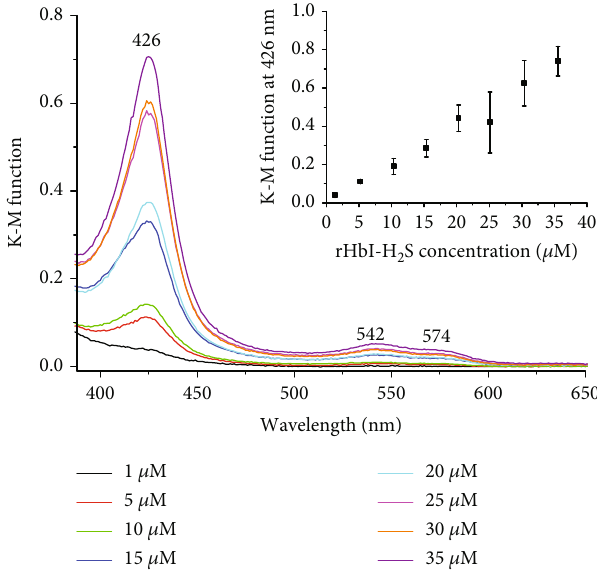
Figure 6: Spectra of rHbI-H S at di ff erent concentrations on the 2 surface of the collagen sponge. Inset shows the changes in Kubelka-Munk units at 426nm transition from the rHbI-H complex against met-aquo rHbI